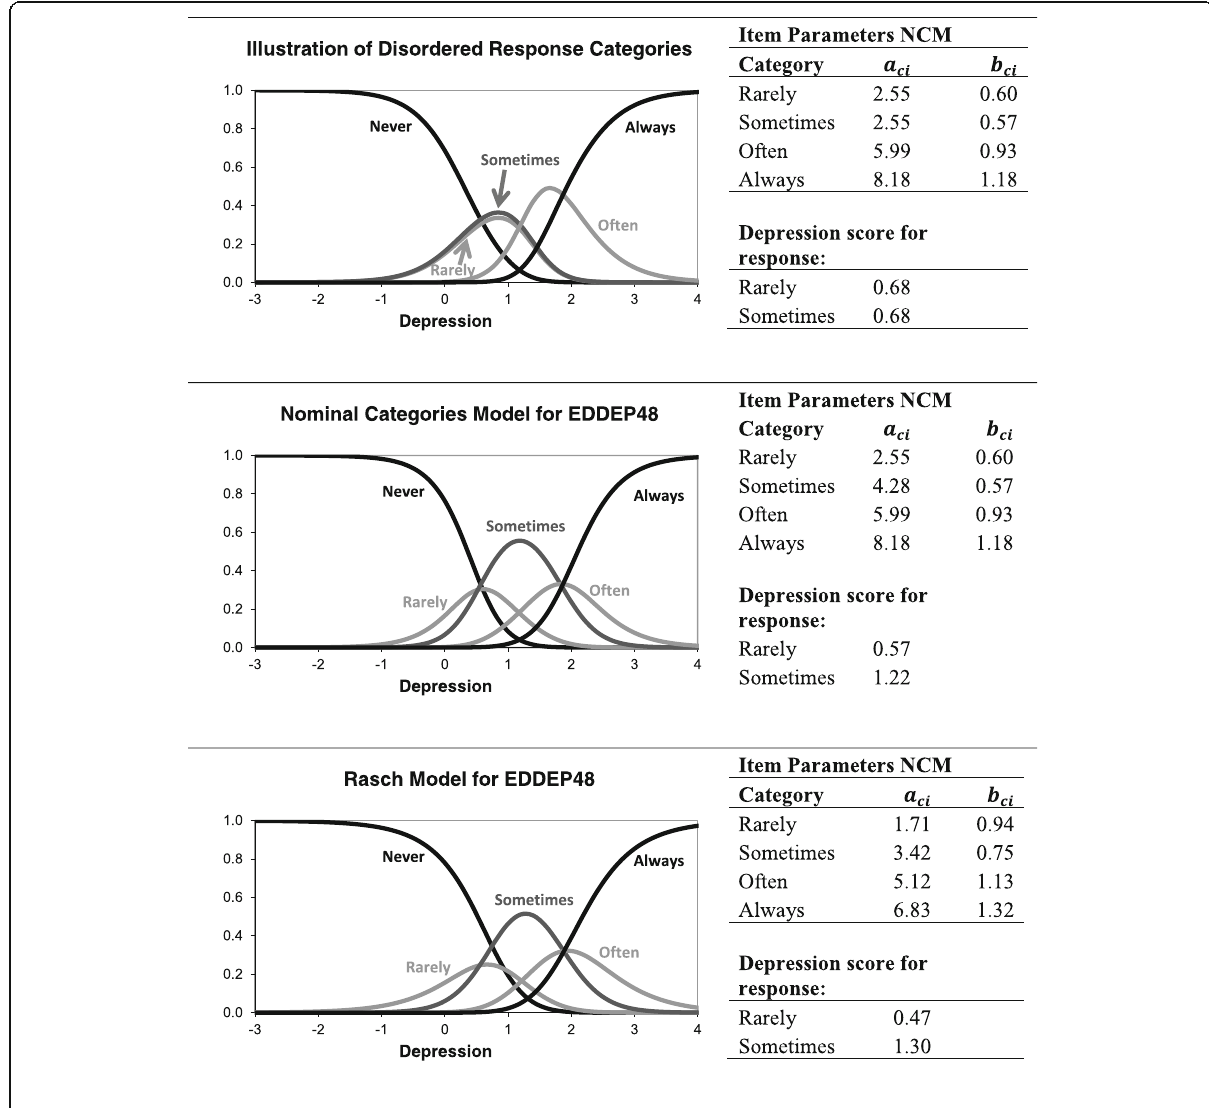
Fig. 7 Evaluation of category order for item EDDEP48 using the nominal categories IRT model